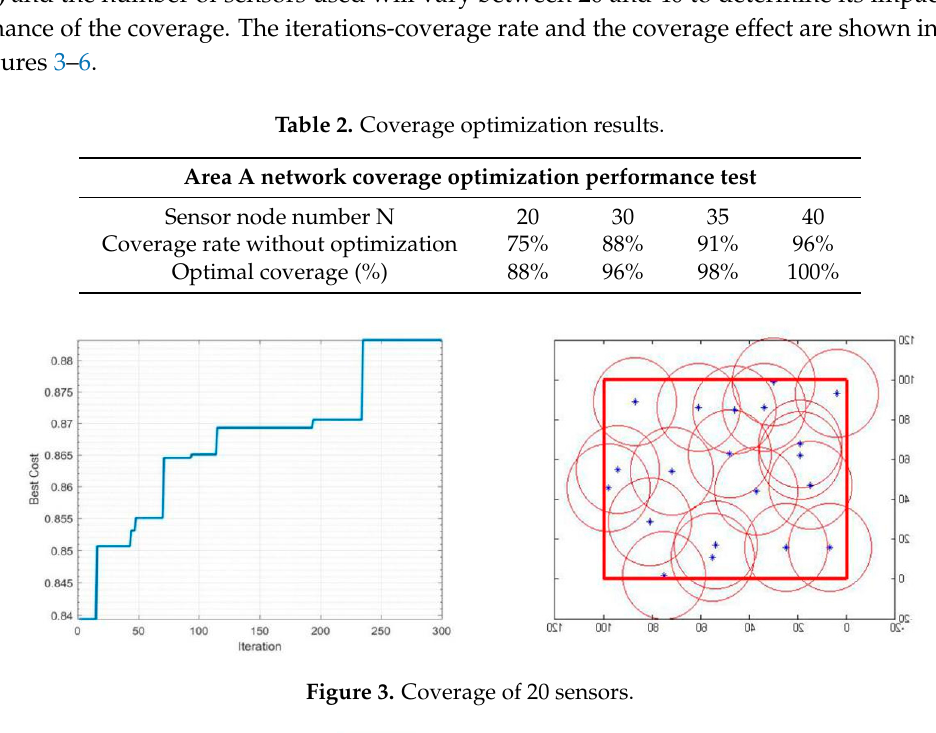
Figure 3. Coverage of 20 sensors.